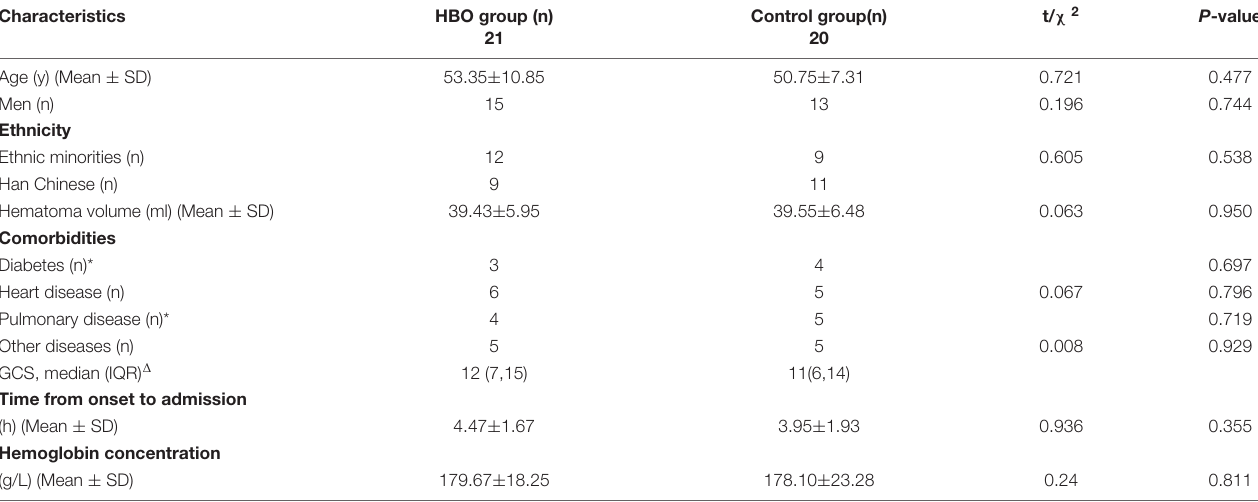
TABLE 1 | Patient characteristics of the HBO and control groups.